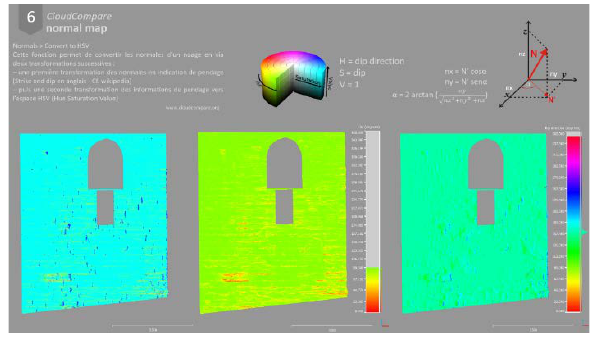
Figure 11. The conversion of the normal in the HSV color space for the creation of normal